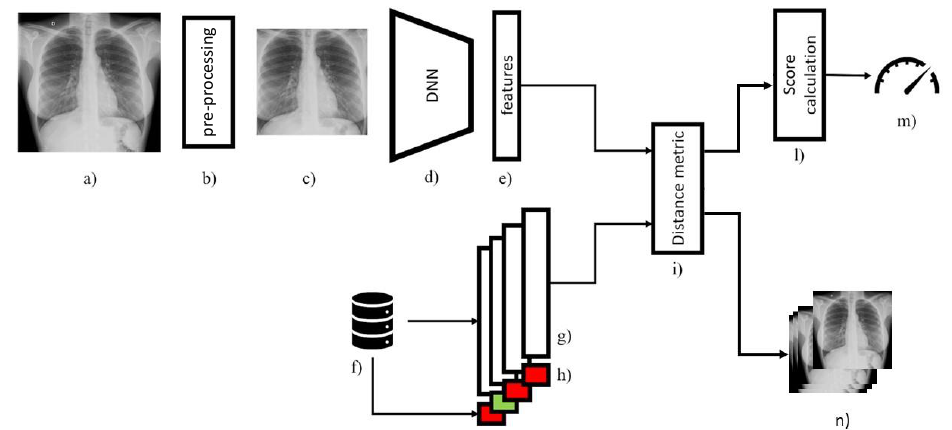
Figure 1. The tool architecture. The image ( a ) is pre-processed by algorithm ( b ) into the new image ( c ) which is elaborated by deep neural network ( d ) to extract features ( e ). Computer features are compared by the distance metric ( i ) with the previously extracted features ( g ) stored in the database ( f ) with their labels ( h ). The features ( g ) have been calculated on past known cases. Using the similarity information elaborated by ( i ) and labels ( h ) a COVID-19 score ( m ) is computed by stage ( l ). The set of most similar cases from the past ( n ), used for the computation of score ( m ), is returned to support doctor diagnosis and to provide interpretation of result.